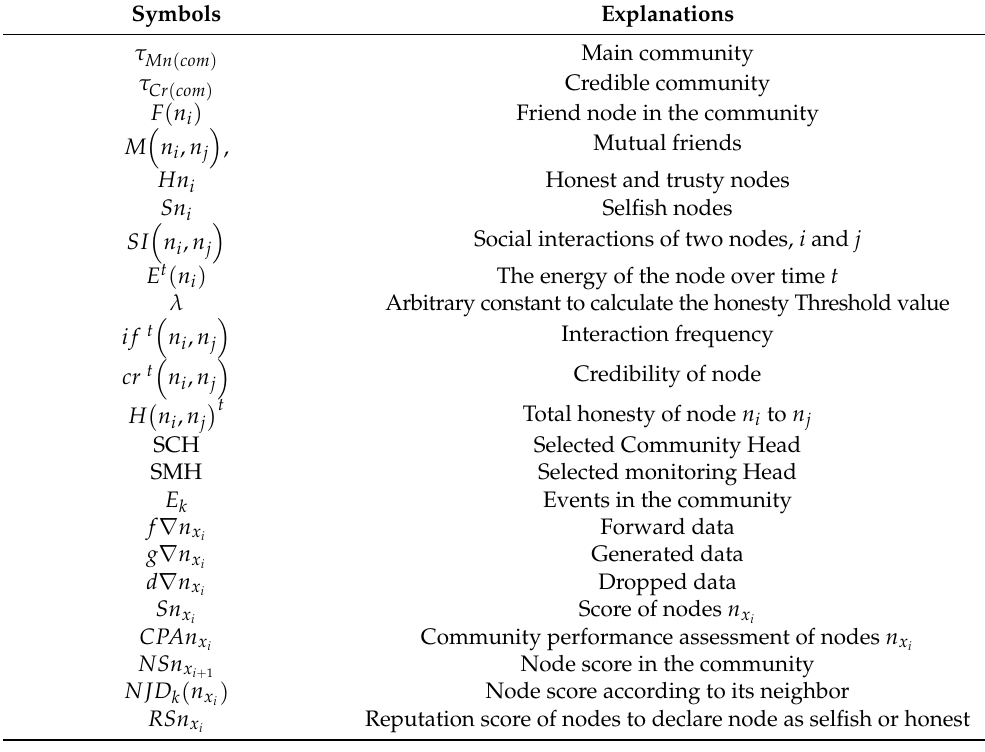
Table 3. Summary of symbols and notation used.